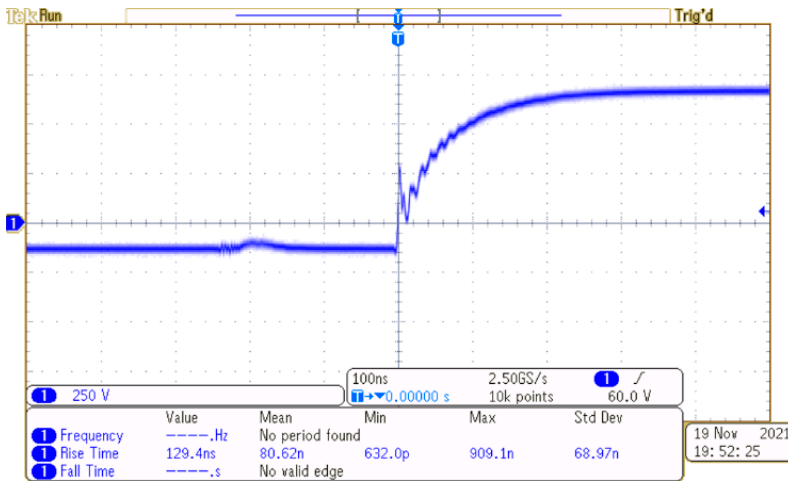
Figure 12. Gate—source voltage rise time for transistor SiC v3 (129 ns).